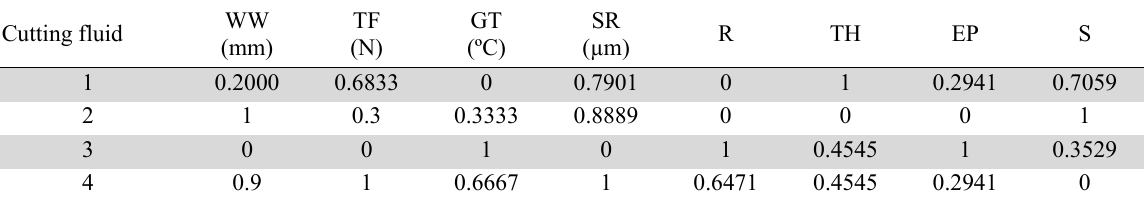
Normalized decision matrix for case study 1 Cutting fluid